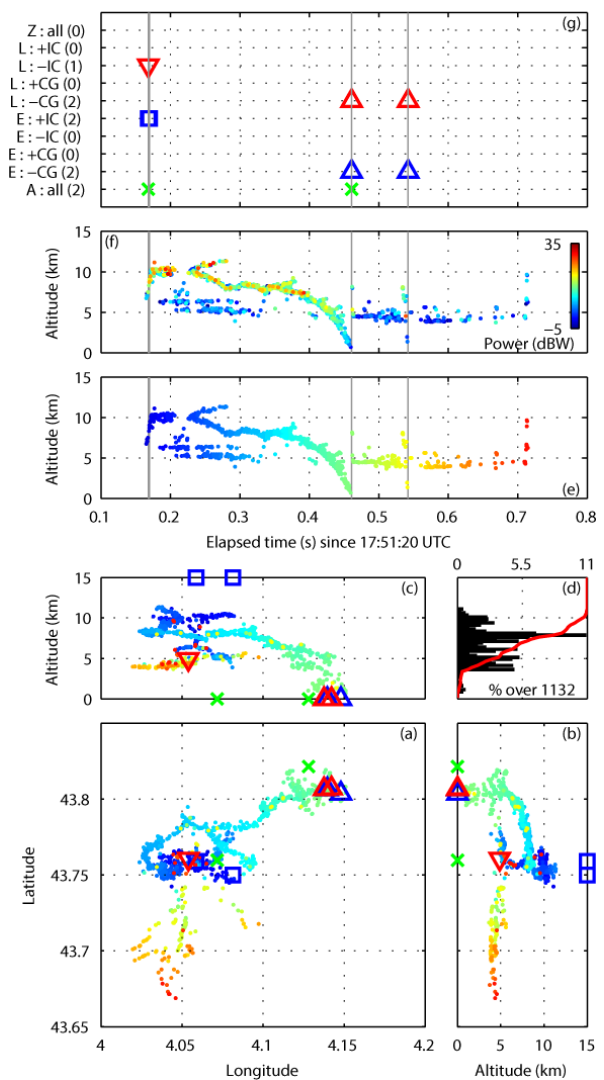
Figure 6. Concurrent lightning records during a bolt-from-the-blue flash recorded on 5 September 2012 at 17:51:20UTC. See Fig. 4 for a description of each